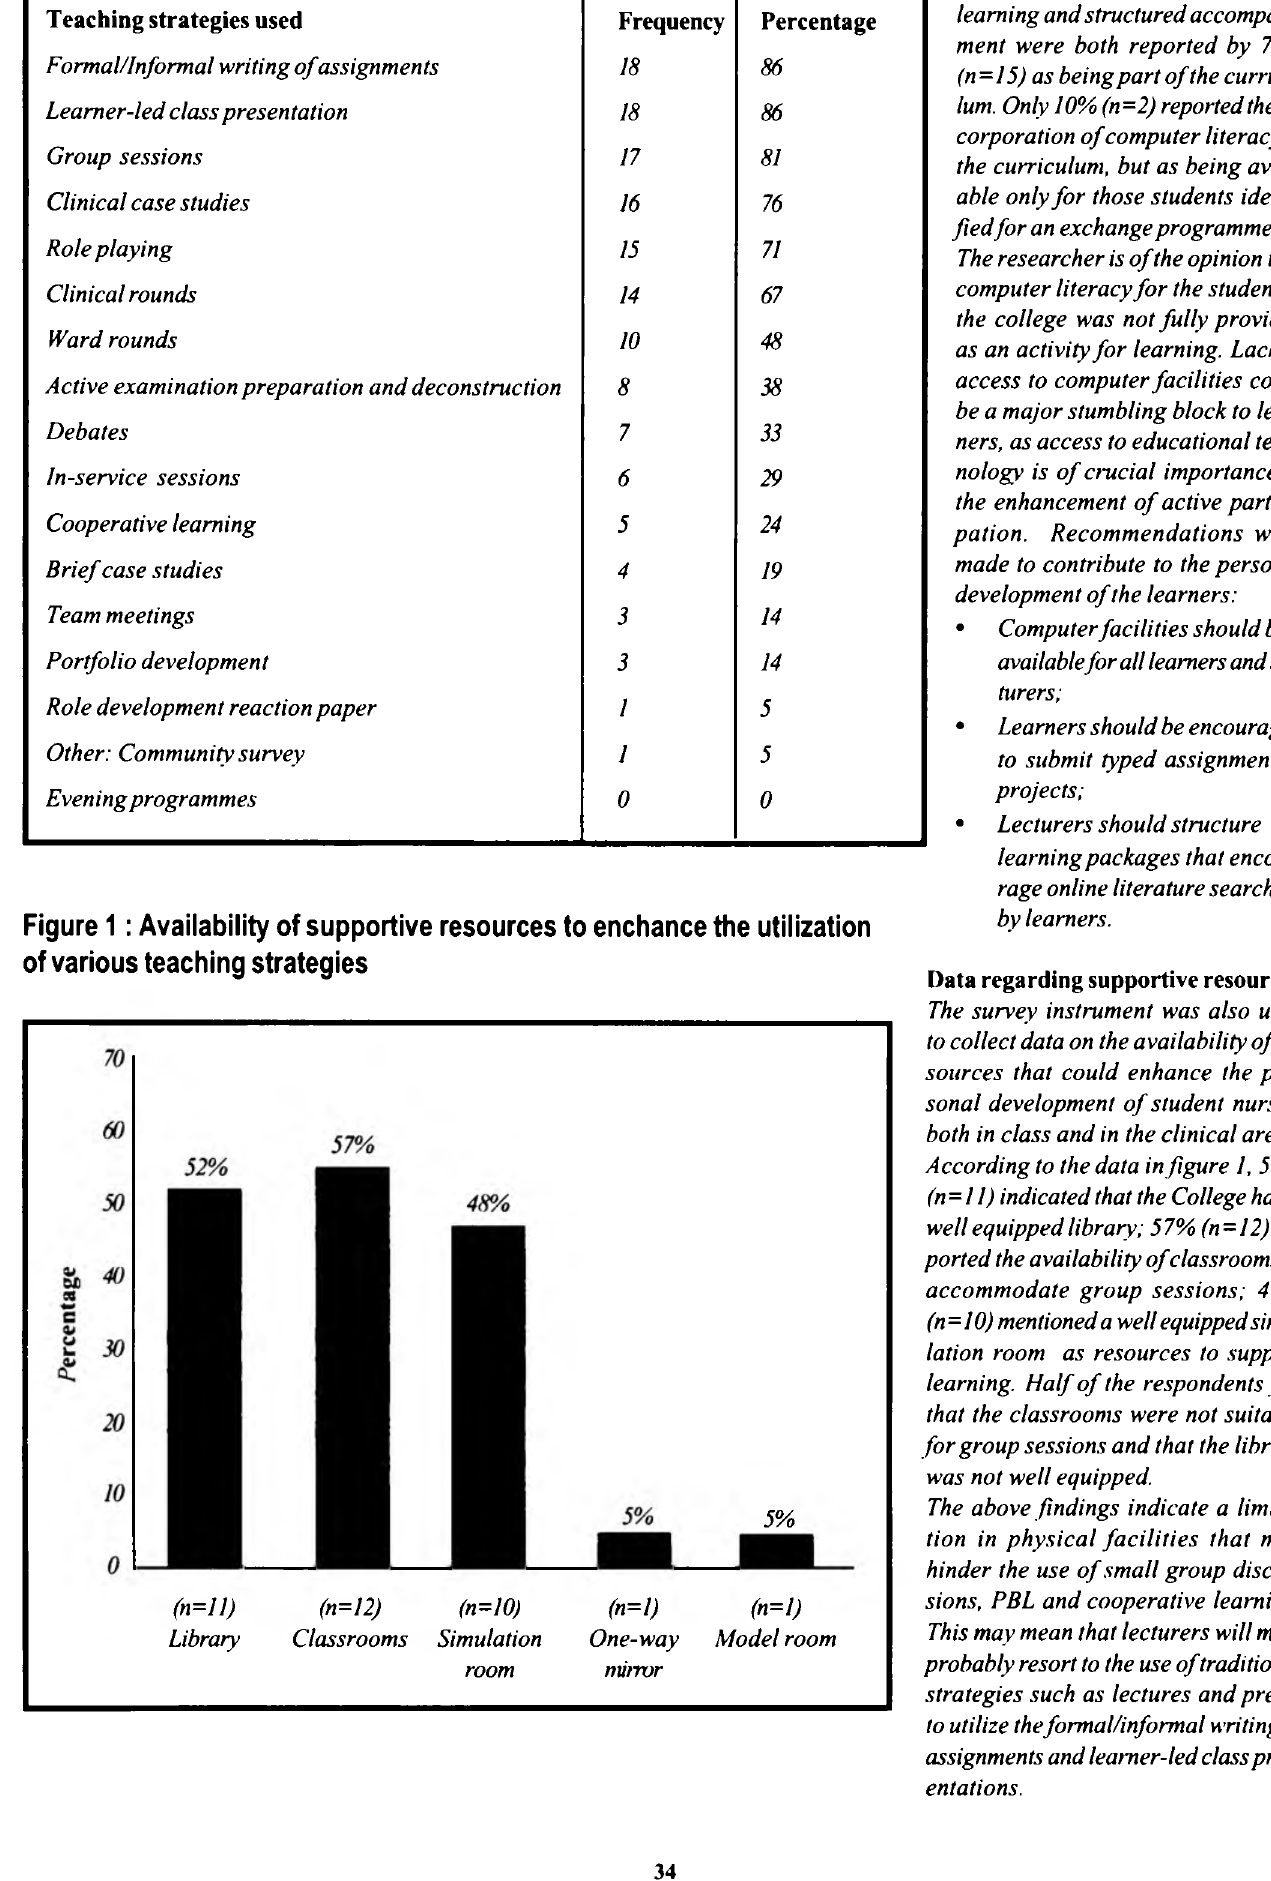
Figure 1: Availability of supportive resources to enchance the utilization of various teaching